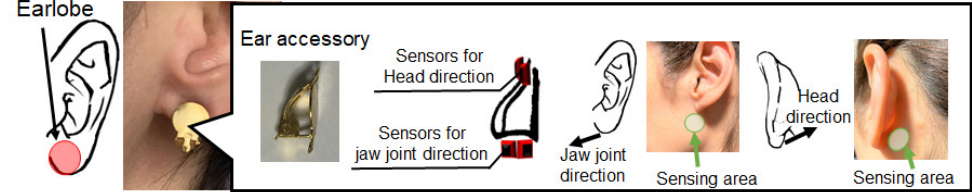
Figure 3. Earlobe-mounted device [11].